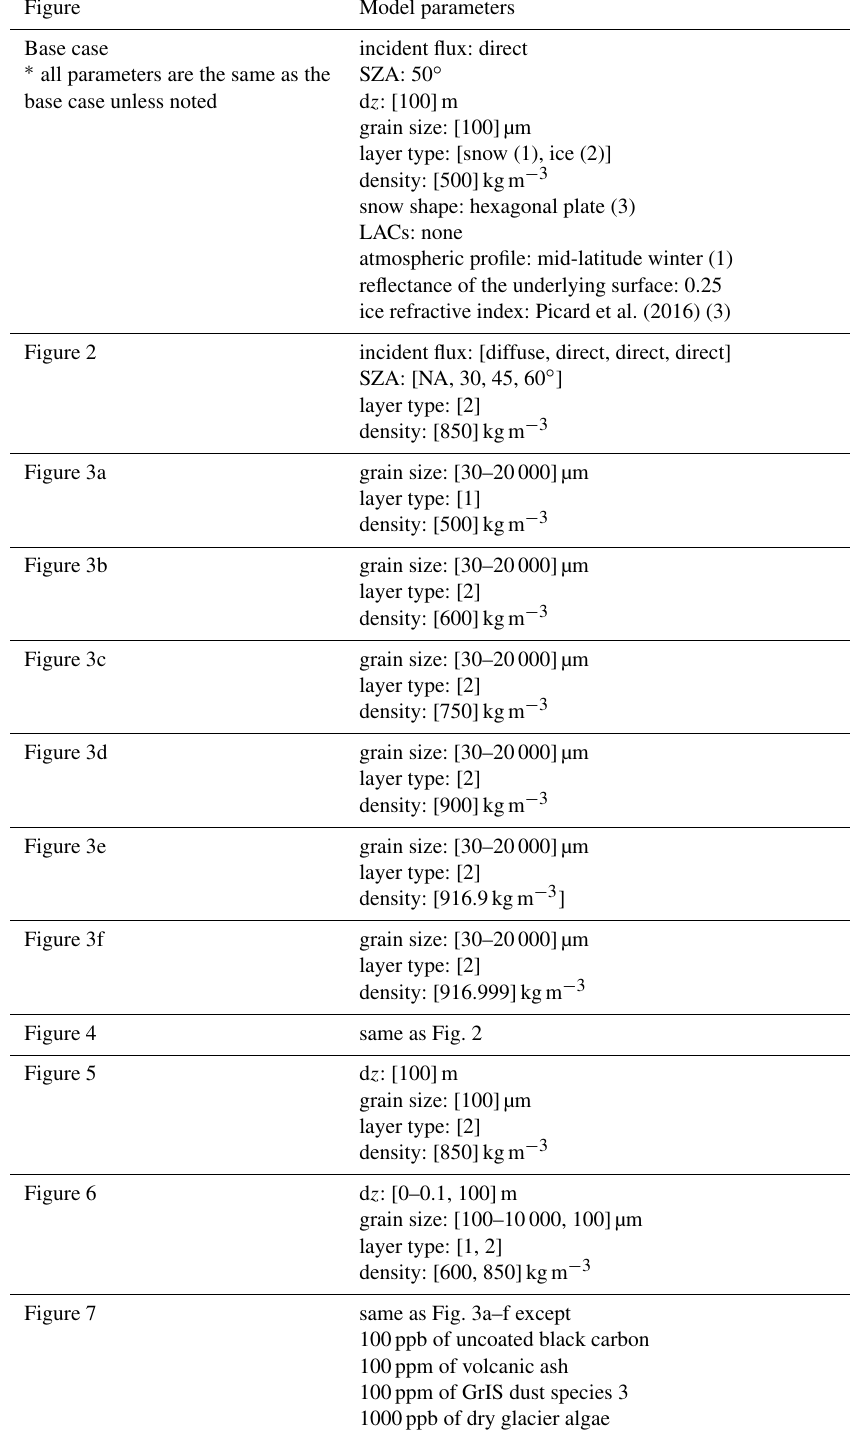
Table A1. Model parameterizations for each run presented in this paper. NA indicates this parameter is not applicable for that particular run. Figure Model parameters Base case ∗ all parameters are the same as the base case unless noted